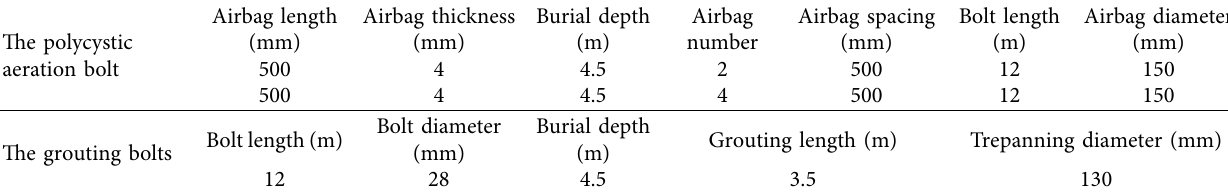
Table 1: The test strategy of pull-out test in situ.